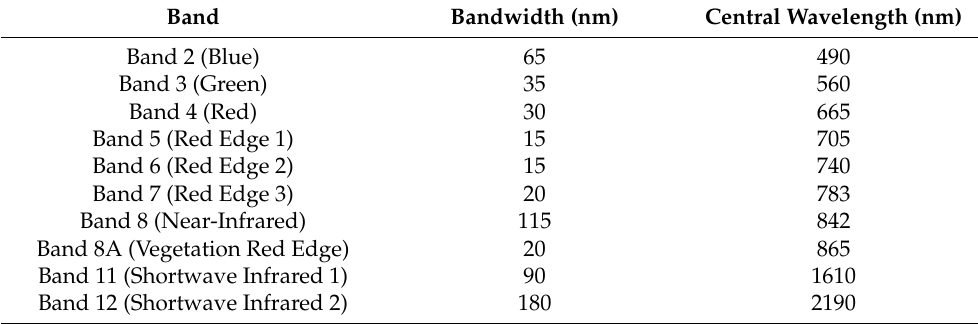
Table 3. Description of targeted spectral bands of Sentinel-2 used in experimental assessment. Band Bandwidth